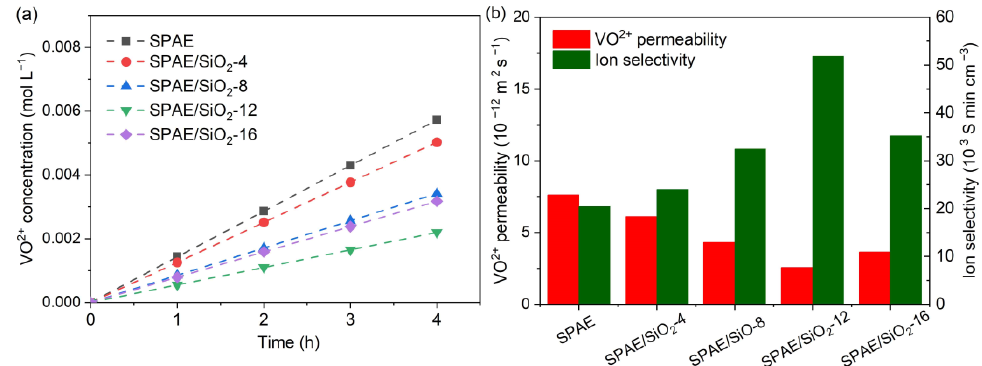
Figure 6. ( a ) Permeated VO 2+ concentration as a function of time and ( b ) VO 2+ permeability and ion selectivity of the SPAE and SPAE/SiO 2 composite